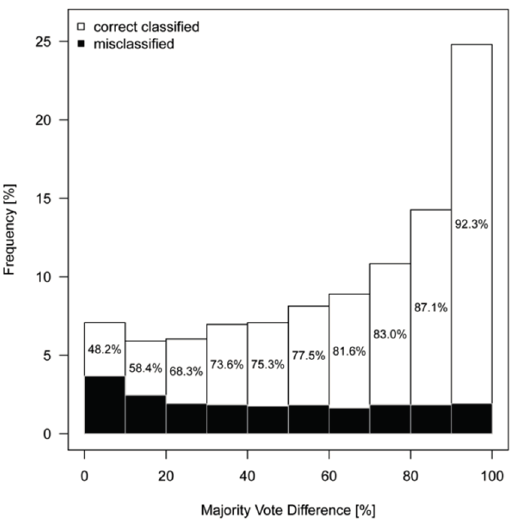
Figure 11. Evaluation of the information provided by the classification margin for the four test sites samples (C). For each class of classification margin (“majority vote difference”) is shown the frequency of correct and erroneous classification. The values inside the bars indicate the percentage of correct